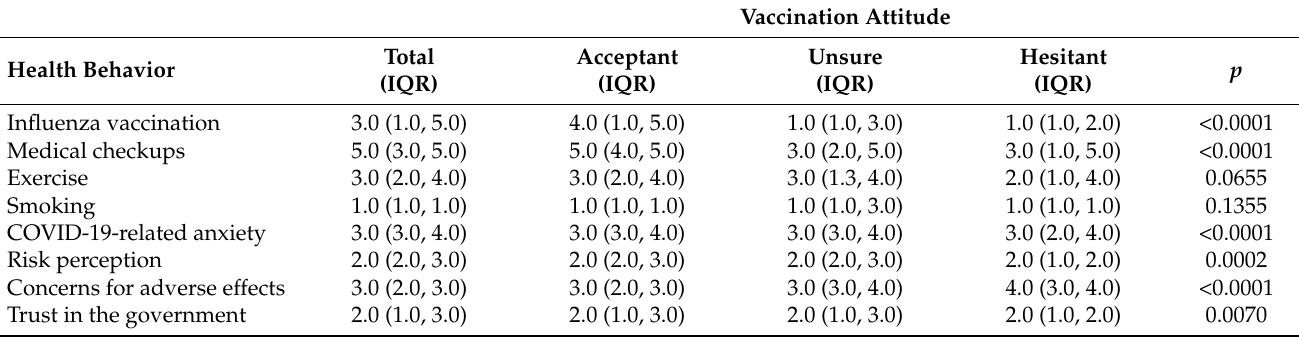
Table 3. Health-related behavior, COVID-19-related psychological variables, and vaccination attitude in September 2021.